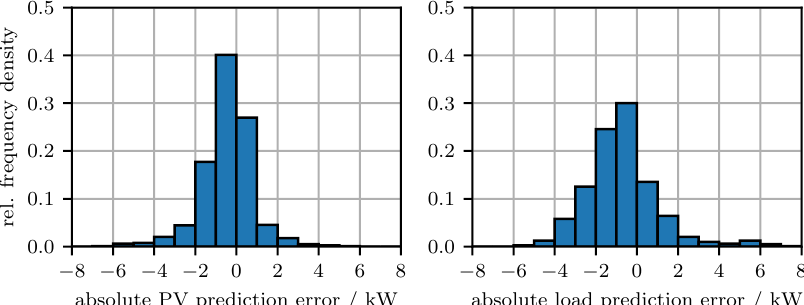
Figure 9. Relative frequency density of the prediction errors for the PV power forecast and the power demand forecast compared to simulation data (retrieved from historic measurement data) in the production facility in Scenario 1.